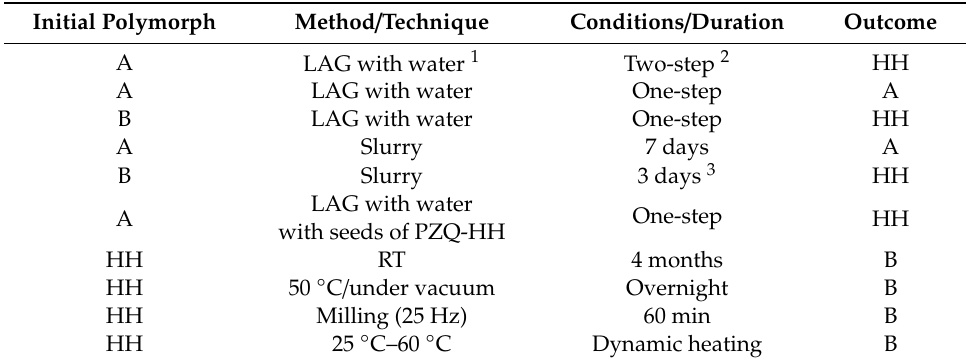
Table 1. Nature of Praziquantel polymorphs obtained by di ff erent processes.